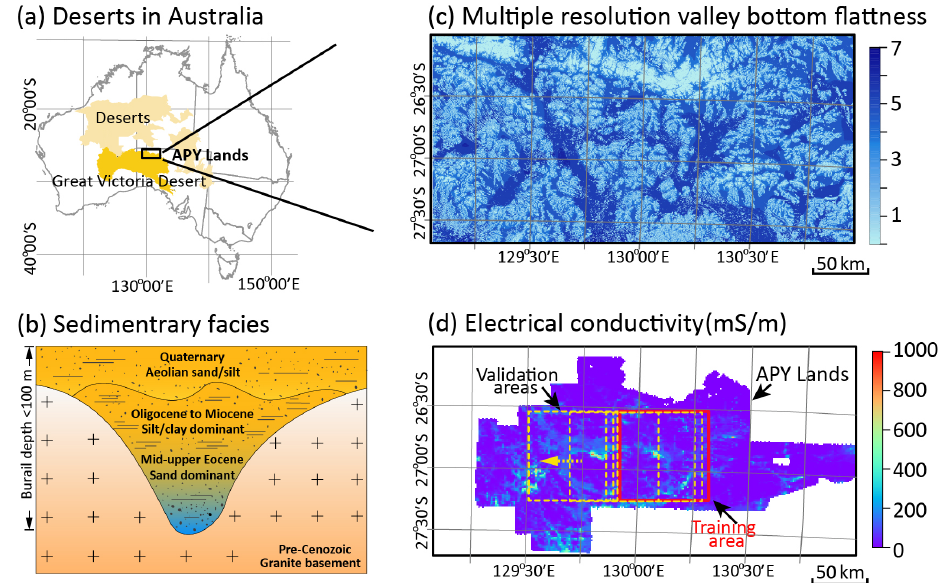
Figure 3. Datasets for delineating 3D paleovalley in the Anangu Pitjantjatjara Yankunytjatjara (APY) Lands of South Australia: (a) location of the largest deserts in Australia and (b) general conceptual model of paleovalley sedimentary facies revealed by over 90% borehole logs, (c) multiple resolution valley bottom flatness index, and (d) electrical conductivity (at depths of 30 to 40m with a horizontal resolution of 400m) inferred by airborne electromagnetic surveys in the APY Lands, forming an indicator of paleovalley